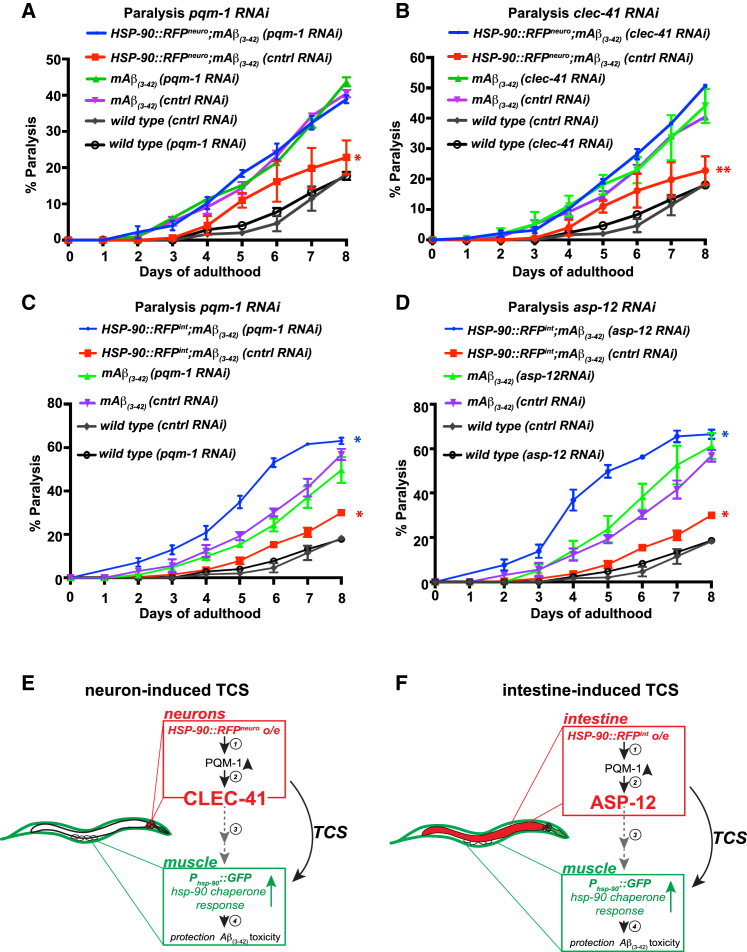
The pqm-1-Regulated Immune Factors clec-41 and asp-12 Are Required for Neuron- and Intestine-Induced TCS, Respectively, to Protect against Aβ(3-42) Toxicity in the Muscle(A) pqm-1 RNAi exacerbates paralysis of HSP-90::RFPneuro;Aβ(3-42) compared with control (EV) RNAi.(B) clec-41 RNAi exacerbates paralysis of Aβ(3-42) animals overexpressing HSP-90 in the neurons (HSP-90::RFPneuro;Aβ(3-42)).(C) pqm-1 RNAi exacerbates paralysis of HSP-90::RFPint;Aβ(3-42).(D) asp-12 RNAi exacerbates paralysis of Aβ(3-42) animals overexpressing HSP-90 in the intestine (HSP-90::RFPint;Aβ(3-42)).(A–D) Paralysis data error bars represent SEM of 3 biological replicates (>100 animals per replicate). Statistical significance was determined by Wilcoxon matched-pairs signed-rank test, comparing HSP-90::RFPneuro;Aβ(3-42) grown on pqm-1 or clec-41 RNAi or HSP-90::RFPint;Aβ(3-42) grown on pqm-1 or asp-12 RNAi with control (EV) RNAi. ∗p < 0.05, ∗∗p < 0.01.(E) Model explaining neuron-induced TCS activation of hsp-90 chaperone expression in the muscle via PQM-1/CLEC-41 signaling. (1) Neuronal overexpression of HSP-90::RFP induces PQM-1 activity locally. (2) Increased PQM-1 activity in the neurons induces transcription of clec-41, which aids in the transmission of a “transcellular chaperone signal” (3) that activates hsp-90 expression in muscle cells (4) to protect them from Aβ(3-42)-associated toxicity.(F) Model explaining intestine-induced TCS activation of hsp-90 in the muscle via PQM-1/ASP-12 signaling. (1) Intestine-specific overexpression of HSP-90::RFP induces PQM-1 activity cell autonomously in the intestine. (2) Active PQM-1 in the intestine induces transcription of asp-12, which is (3) required to induce hsp-90 expression in muscle cells (4) to protect them from Aβ(3-42)-associated toxicity.